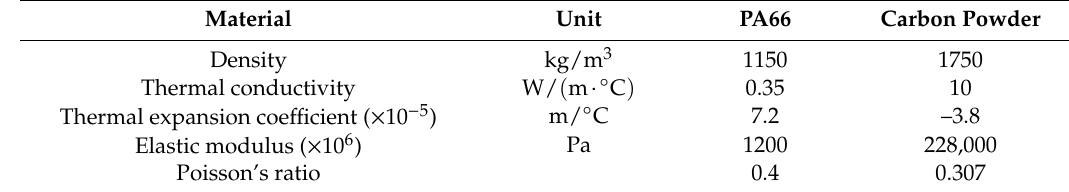
Table 1. Physical properties of raw materials.